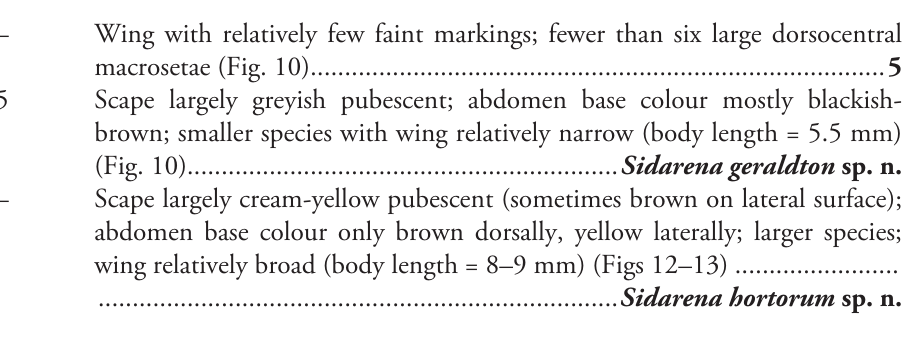
Type material. Holotype male, AUSTRALIA: Western Australia: 158 km S New- man, 9 km N Kumarina Roadhouse, Malaise in wide sandy wash, 21/23.V.2003, M.E. Irwin F.D. Parker, 638 m 24°37.8'S, 117°36.8'E (GPS) (ANIC).